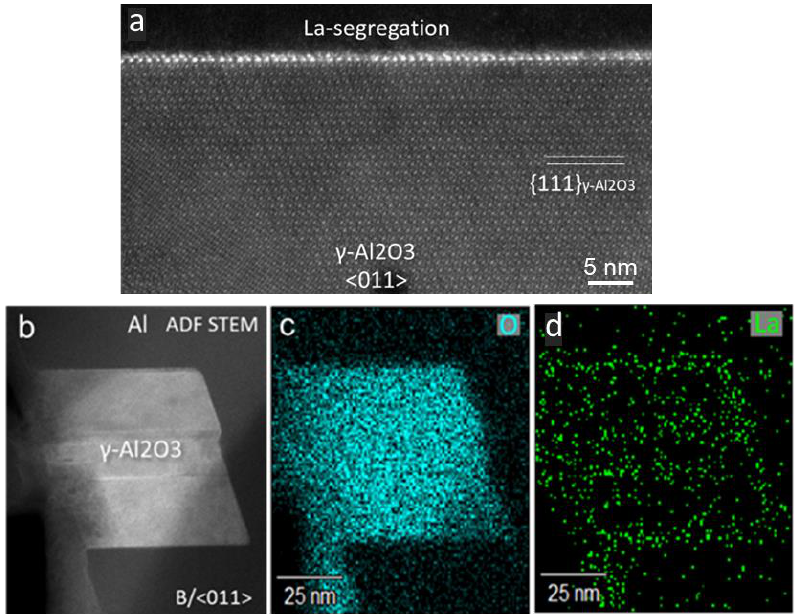
Figure 36. La segregation at Al/ γ -Al 2 O 3 interface [88]. ( a ) STEM Z-contrast HAADF image of Al/ γ -Al 2 O 3 interface for a γ -Al 2 O 3 particle in Al-0.75La alloy; ( b ) STEM ADF image; and ( c , d ) EDS elemental mapping of ( c ) O, ( d ) La, showing La enrichment at the interface.